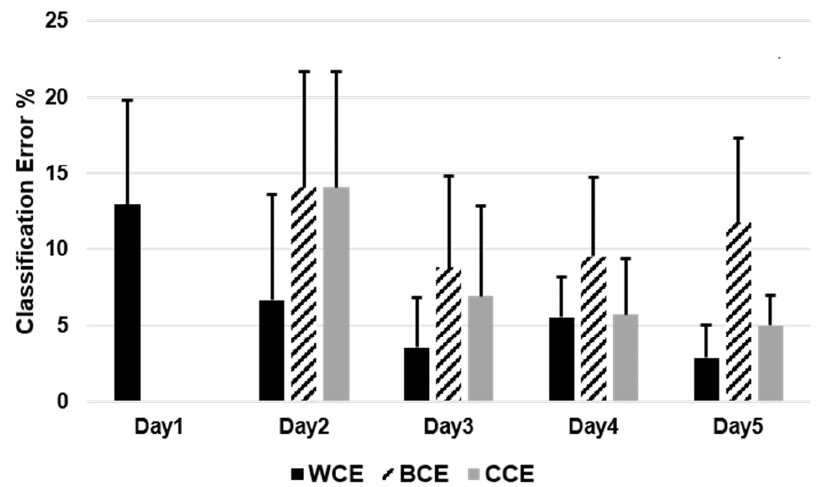
Figure 3. Comparison of percentage classification error (mean ± standard deviation) between each offline train/test scheme over five days.